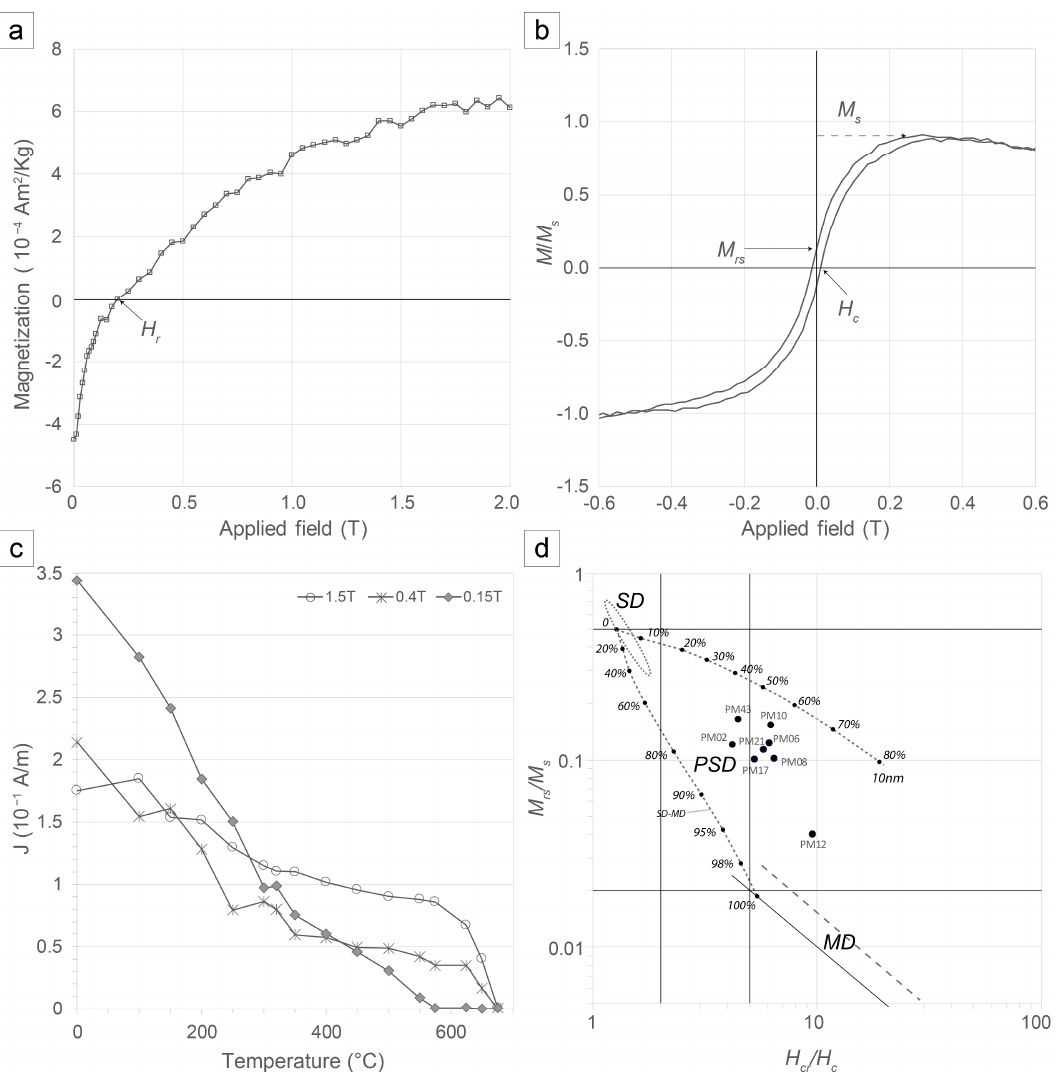
Figure 5. ( a ) IRM backfield acquisition curve, ( c ) hysteresis loop and ( b ) thermal demagnetisation paths of three-axes IRM of the representative sample PM06 (see Figure 3c for stratigraphic position); ( d ) Log–log scatter plot of ratio of saturation remanence to saturation magnetisation ( M rs / M s ) against ratio of remanent coercive force to ordinary coercive force ( H cr / H c ) of all samples analysed for magnetic carrier mineralogy. Black lines delimit variability fields of single domain ( SD ), pseudo-single domain ( PSD ) and multidomain ( MD ) grains after [57]. Dotted lines are theoretical mixing curves of SD + MD (below) and superparamagnetic ( SP)+SD magnetites after [58]. The ellipse in the upper left corner highlights values of greigite-bearing samples from a global compilation by [59].